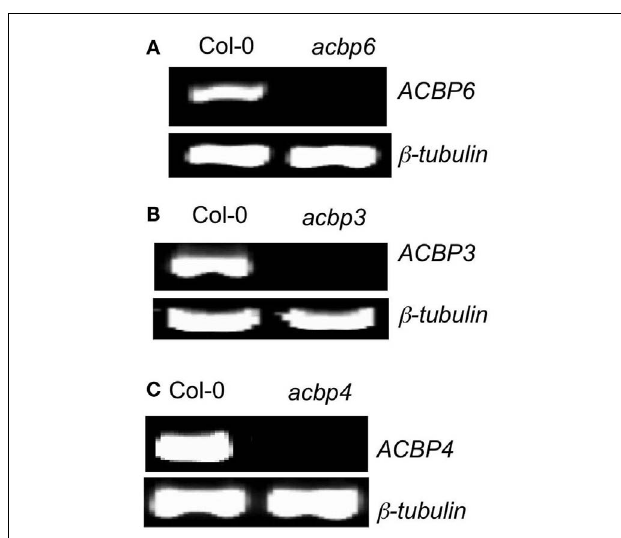
FIGUREA1 | Reverse transcription-PCR analysis showing ACBP transcript levels in wild-type (Col-0) and acbp3 (A), acbp4 (B), and acbp6 (C) mutant plants. The level of β -tubulin was used as an internal control to normalize the amount of cDNA template.The RT-PCR analysis was repeated with two independent cDNA templates per genotype.